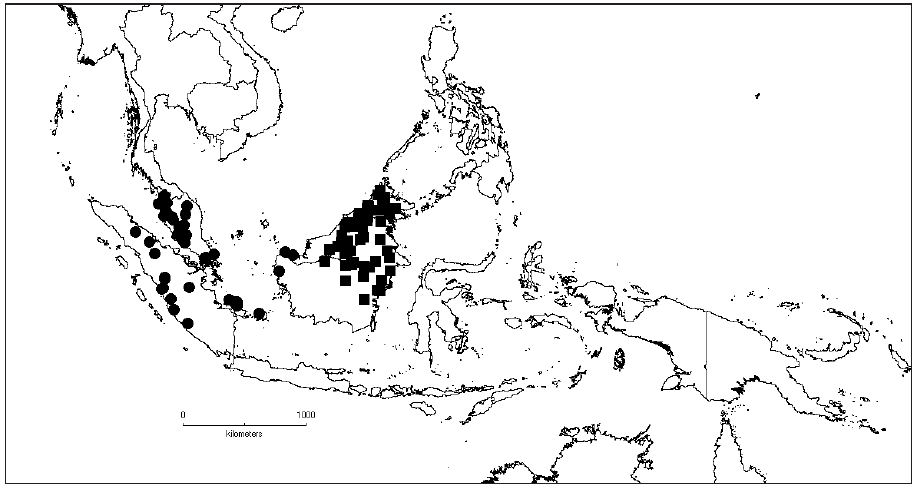
Map 22. Distribution of D. pallida ( ● ) and D. pulchra ( ■